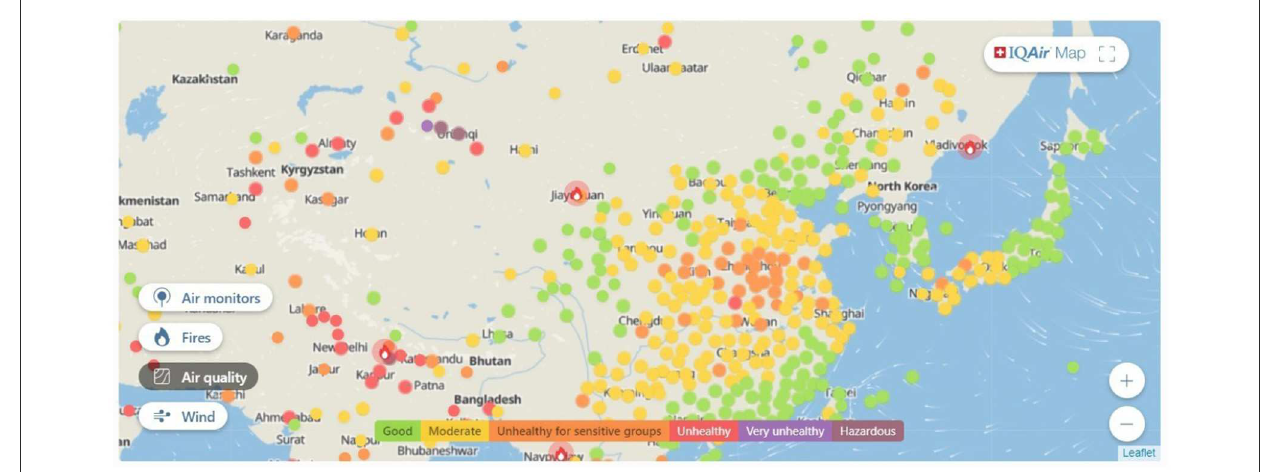
FIGURE3 Air quality in China by IQAir.com. Red means “unhealthy” (data recorded on